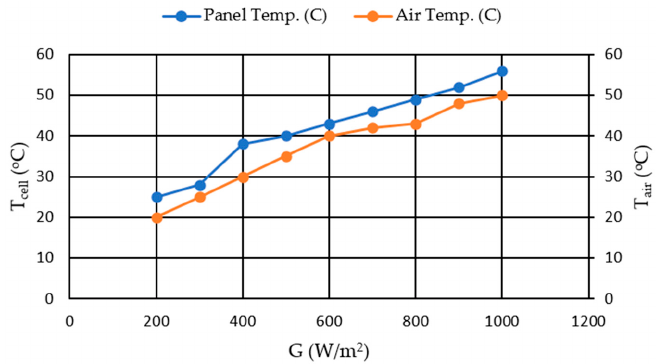
Figure 11. Relation between solar radiation and panel temperature (1 August 2019).